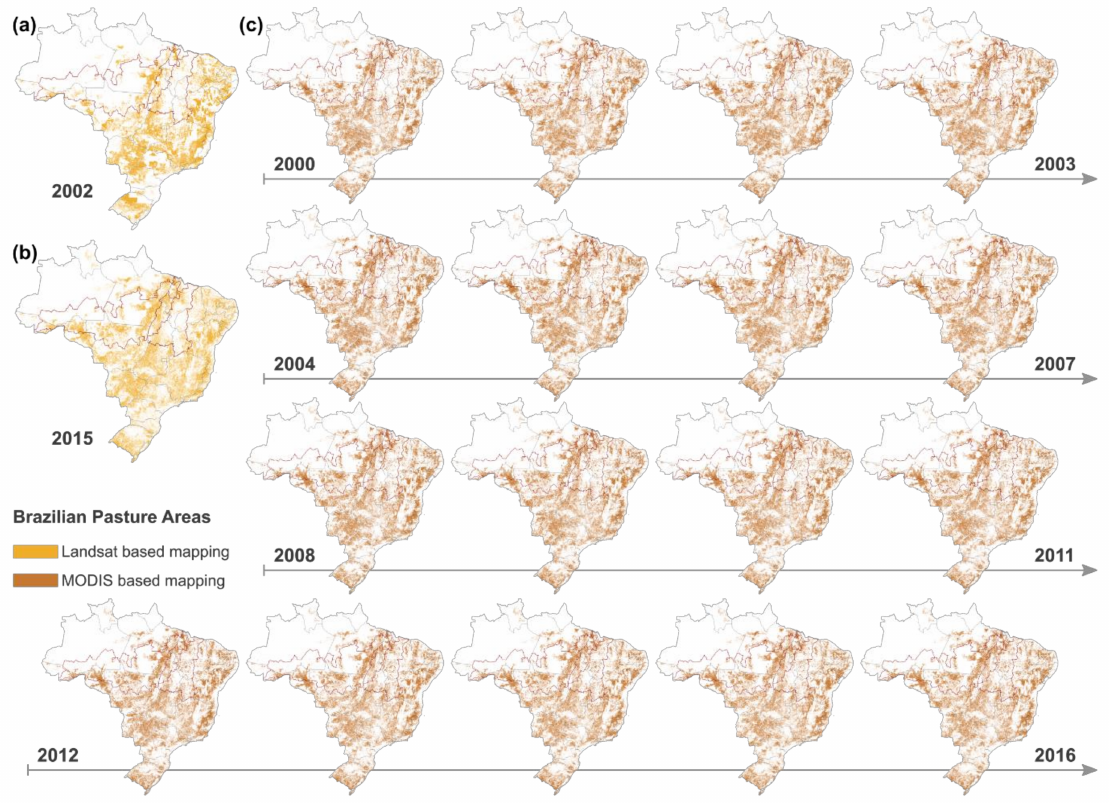
Figure 3. ( a ) The Brazilian pasture area as mapped by the segmentation and visual inspection of Landsat 7 images, with reference in 2002 [16]; ( b ) The Brazilian pasture area as mapped by the automated classification of Landsat 8 Images, with reference in 2015 [13]; ( c ) The Brazilian pasturelands time series, according to the automated classification of MODIS images obtained between 2000 and